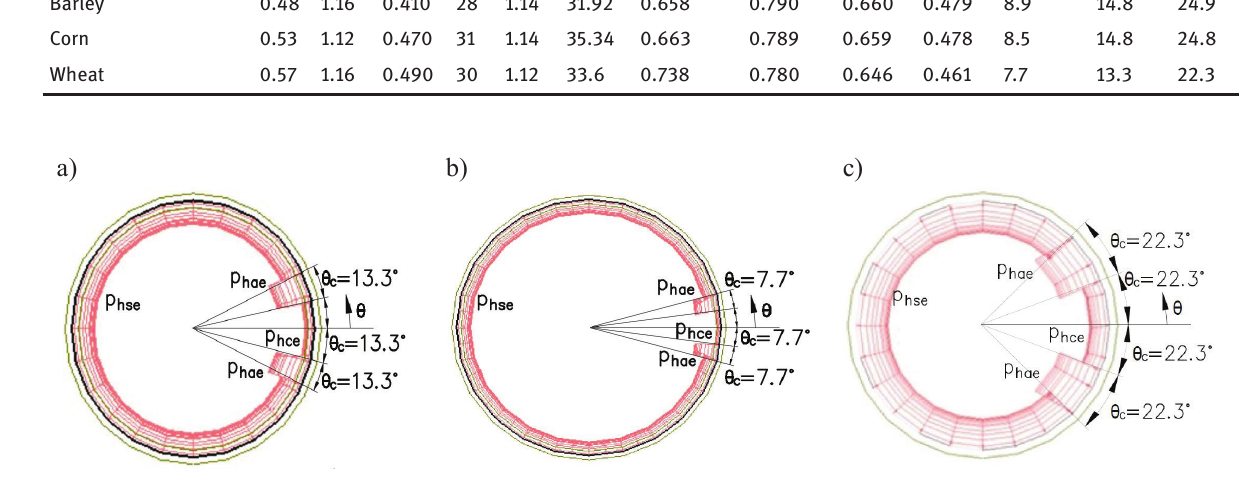
Fig. 3. Distribution of pressure on the perimeter of the silo, taking into account non-centric flow Figure 3: Distribution of pressure on the perimeter of the silo, taking into account a non-centric flow channel while emptying the wheat silo channel while emptying the wheat silo with the diameter of 10 m: a) rr with a diameter of 10 m: a) r = 0.25 r , b) r = 0.4 r and c) r = 0.6 r. c c c